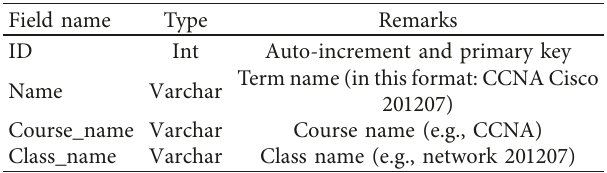
Table 3: Class allocation.